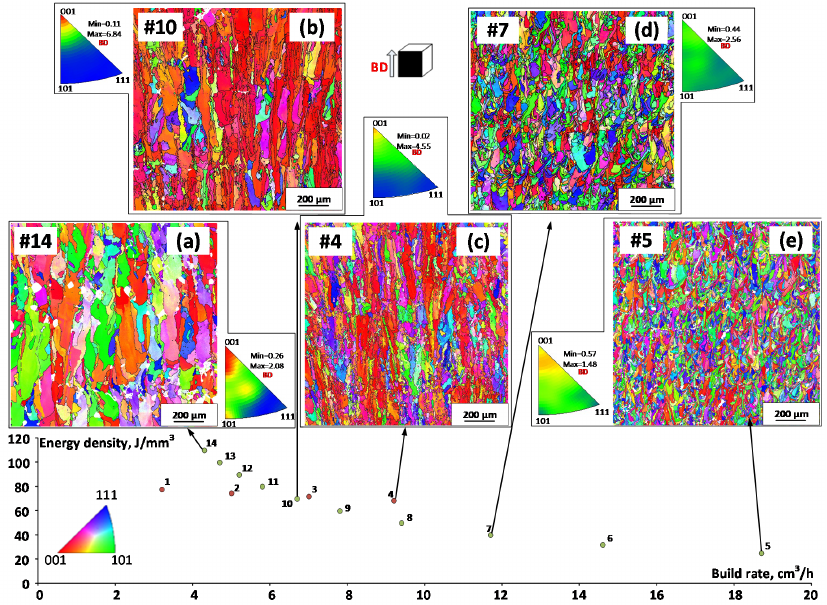
Figure 6. Microstructure and inverse pole figures of the as-built alloy presented in increasing build rate order: ( a ) 14, ( b ) 10, ( c ) 4, ( d ) 7 and ( e ) 5. Table 5. Results of the structural analysis of selected specimens presented in decreasing laser power density order.